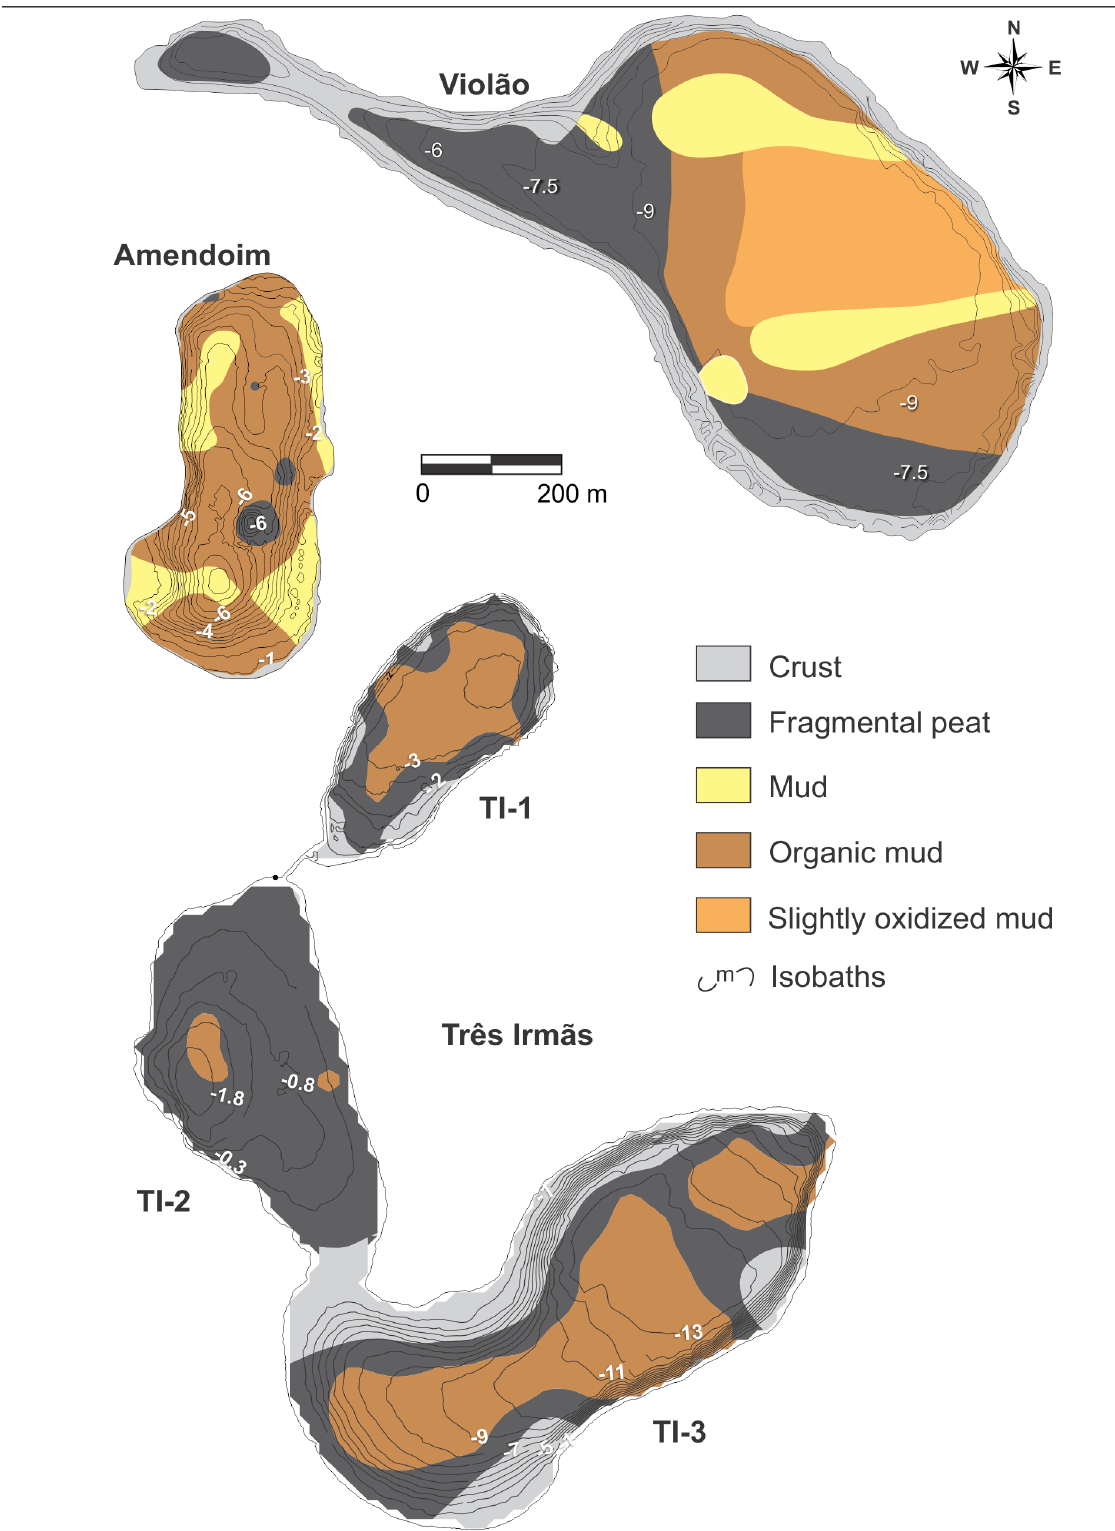
Figure 5 - Sedimentological map of the Violão, Amendoim and Três Irmãs